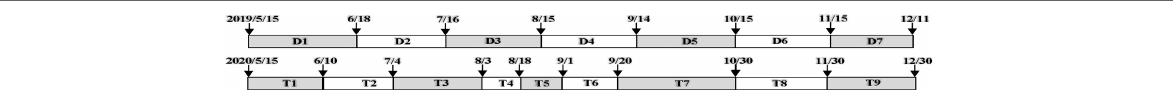
FIGURE 2 | Schematic maps illustrating the monitoring periods of oyster and barnacle recruitment in 2019 and